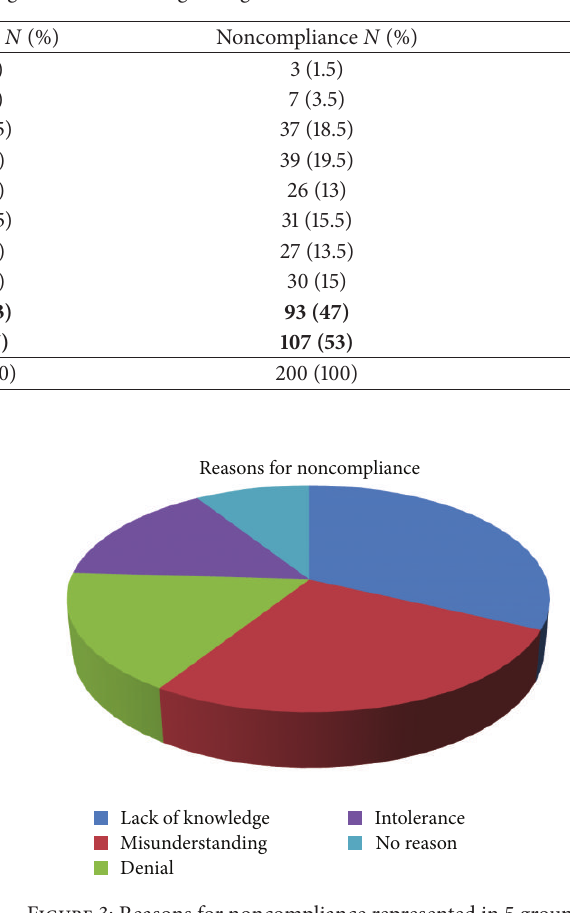
Table 2: General compliance according to number of drugs and gender.